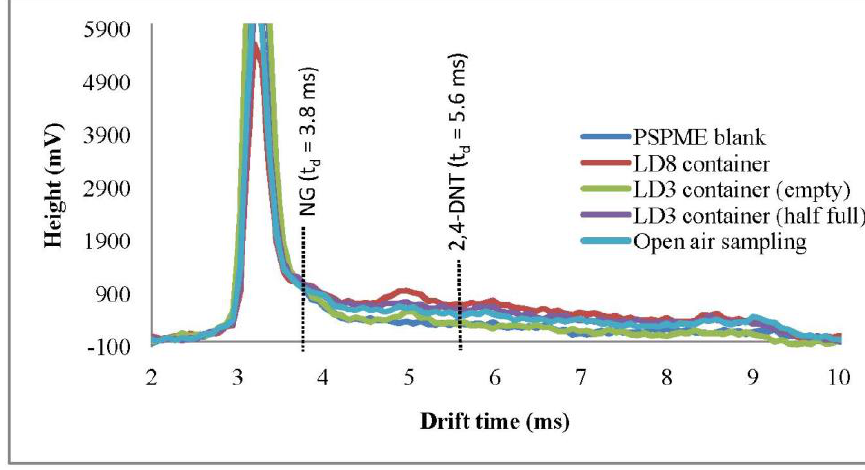
Figure 3. Plasmagrams for dynamic PSPME sampling (1 min.) in cluttered environments from a local shipping facility. Sampling was performed in LD3 (4,500 L) containers and LD8 (6,880 L) containers as well as open air sampling of the location with indication of detection windows for NG and 2,4-DNT (drift time (t ) of 3.8 ms and 5.6 ms, d